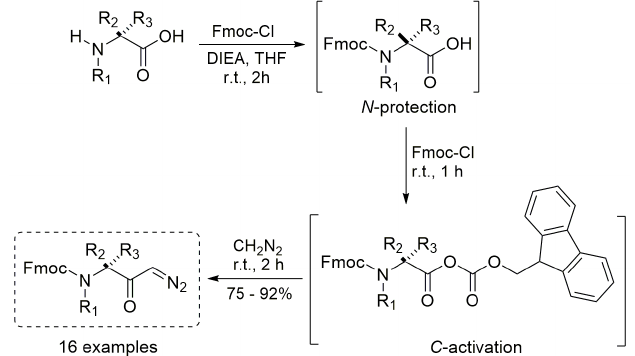
Figure 12 - The “one-step” route to the synthesis of α-amino diazoketones published by Siciliano and